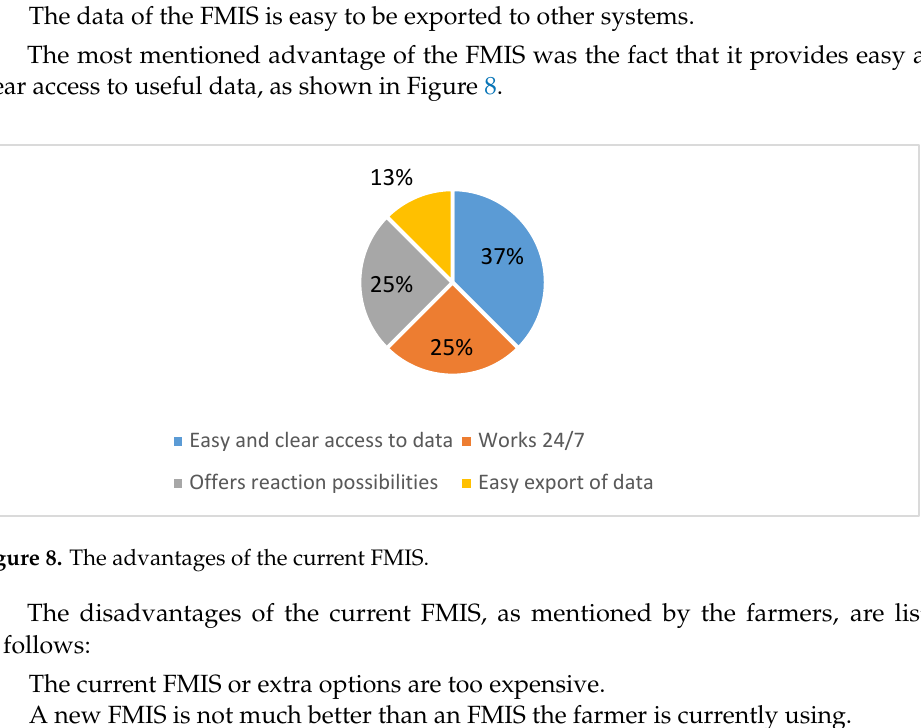
Figure 9. The disadvantages of the current FMIS.